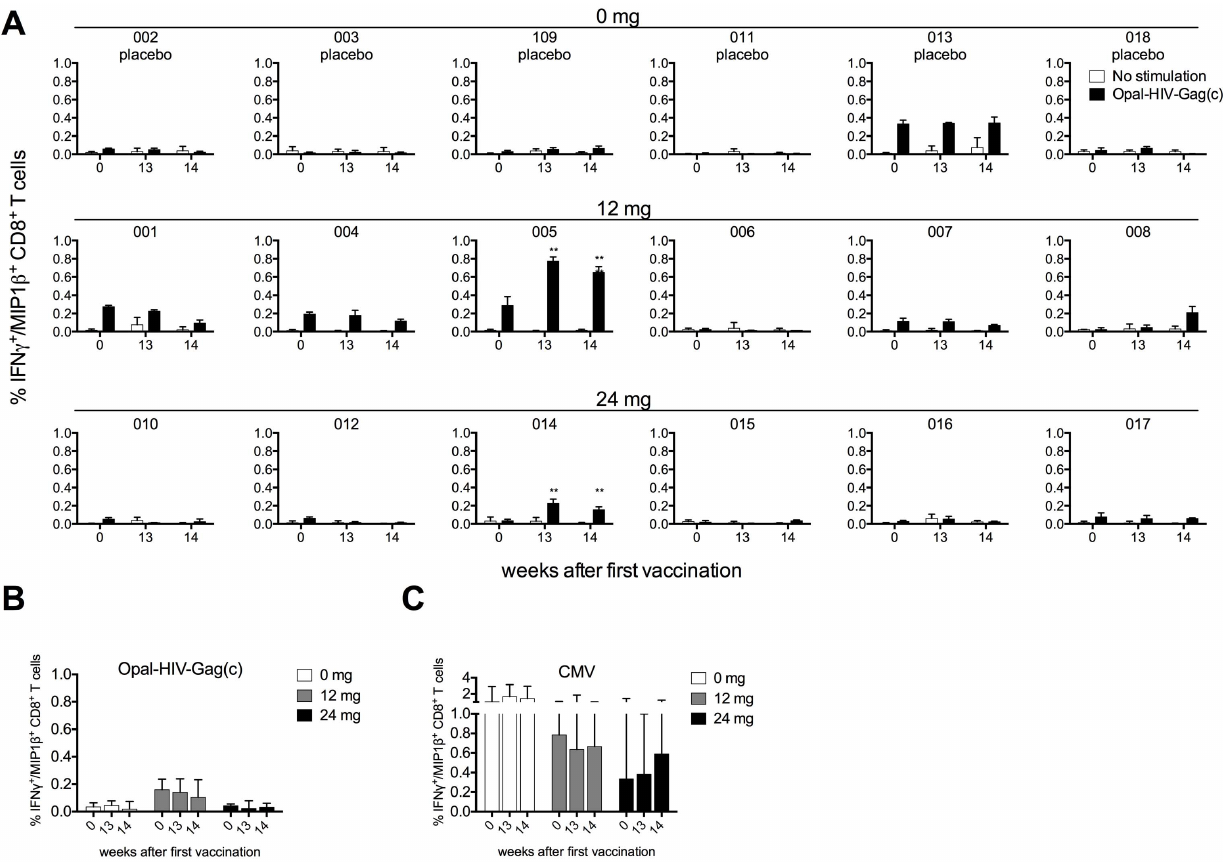
Figure 4. OPAL-HIV-Gag(c) and CMV peptide pool specific CD8 + T-cell responses before and after vaccination. All six subjects from each dose group (0 mg, 12 mg and 24 mg) were tested for OPAL-HIV-Gag(c) specific or no peptide (no stimulation) responses by ICS shown as IFN c + /MIP1 b + double positive CD8 + T-cells processed from frozen PBMCs derived at week 0, 13 and 14 after first vaccination expressed as the mean of triplicate stimulations (A) and expressed as median values within dose groups with error bars representing inter quartile ranges for OPAL-HIV- Gag(c) (B) and for CMV specific CD8 + T-cell responses (C).